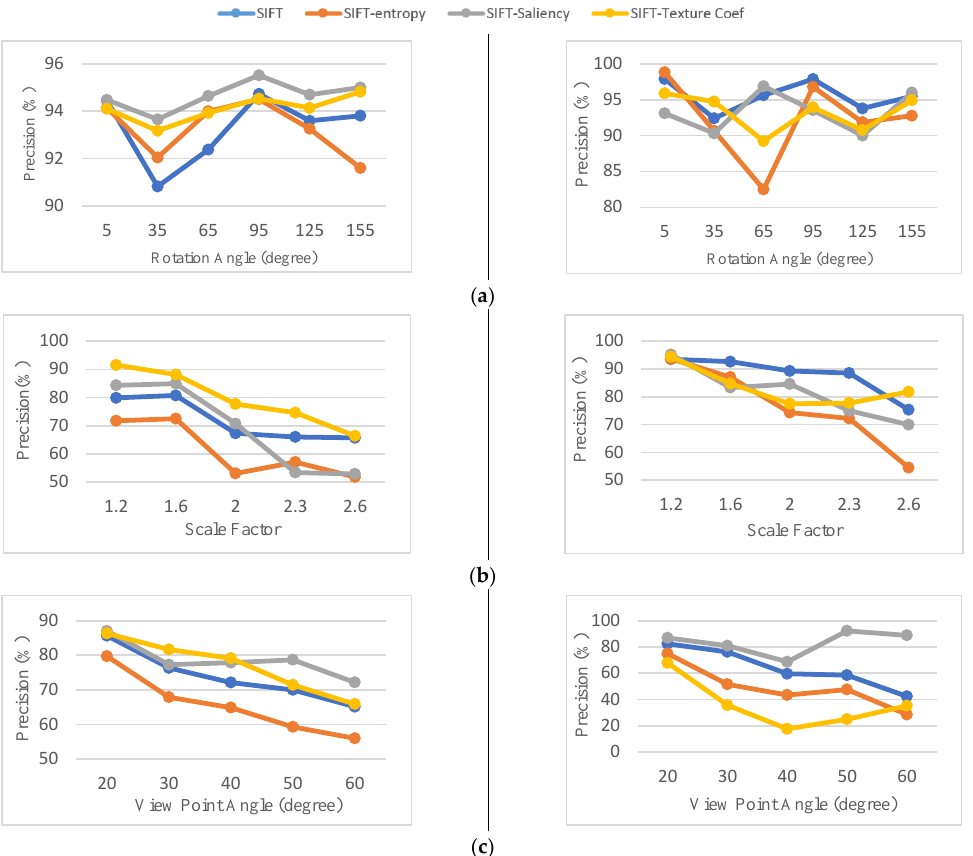
Figure 8. Precision results for the synthetic image pair of S1 (left column) and S2 (right column). ( a ) Rotation, ( b ) scale, ( c ) viewpoint change.